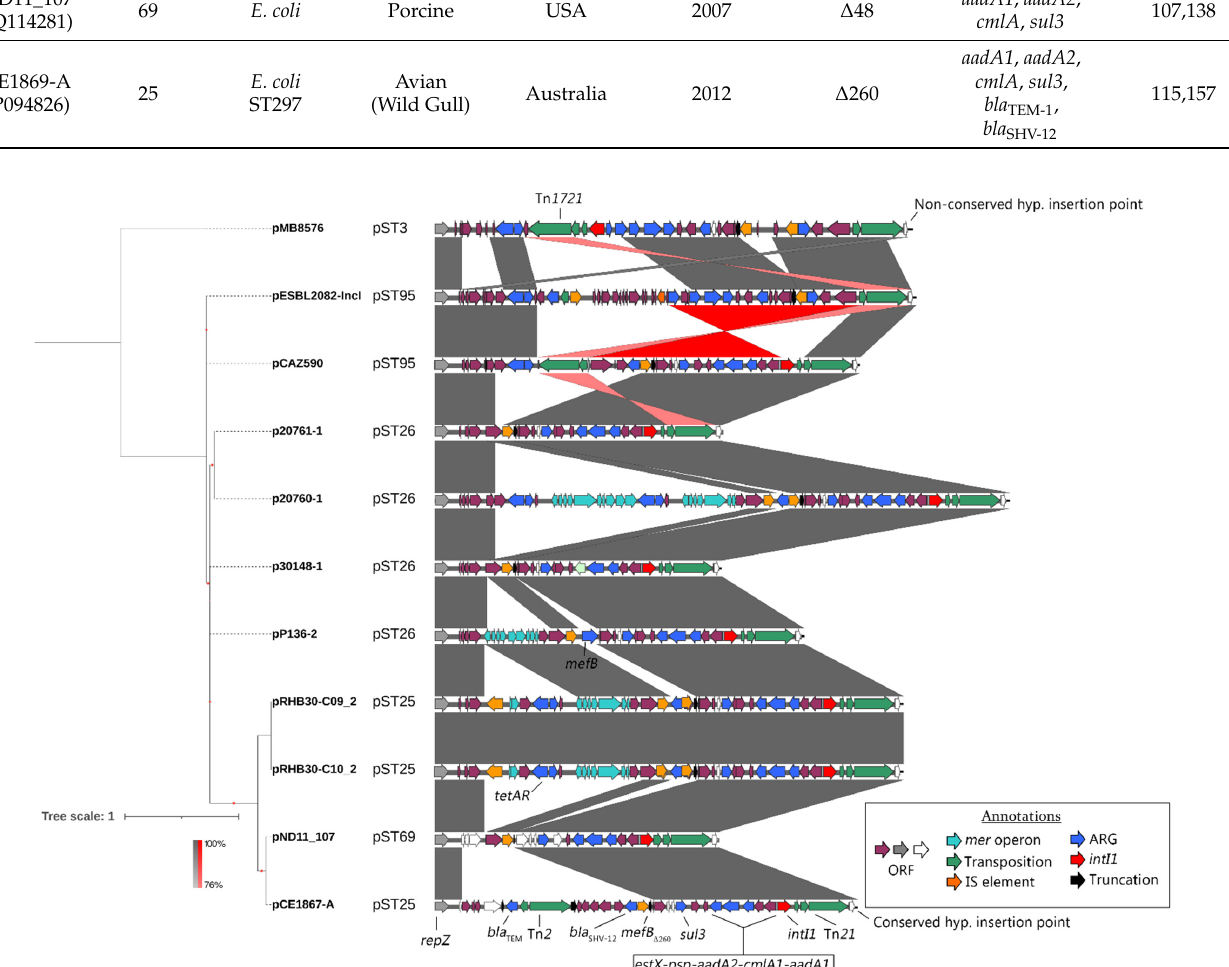
Figure 4. Whole-plasmid SNV phylogeny (mid-point rooted) of sul3 -encoding I1 plasmids with linear comparisons of complex resistance regions. Tree scale is presented in SNVs per site. BLASTn similarity scale is shown in the bottom left, with red indicating an inversion of sequence.